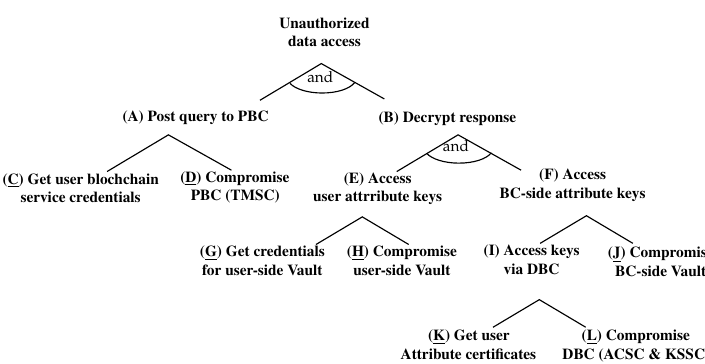
Figure 8. Unauthorized data access attack tree for the HMBAC